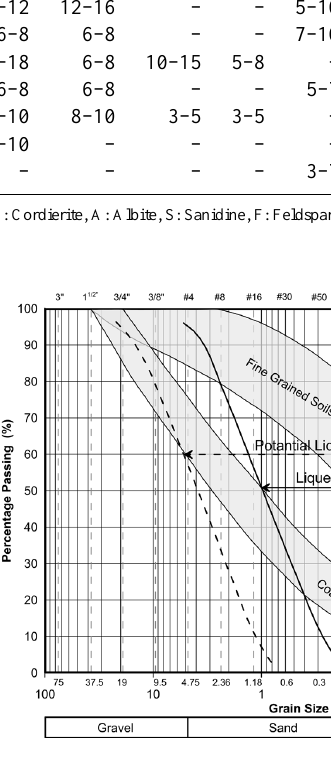
Fig. 14. Grain size distribution interval for liquefaction susceptibil- ity of the soil